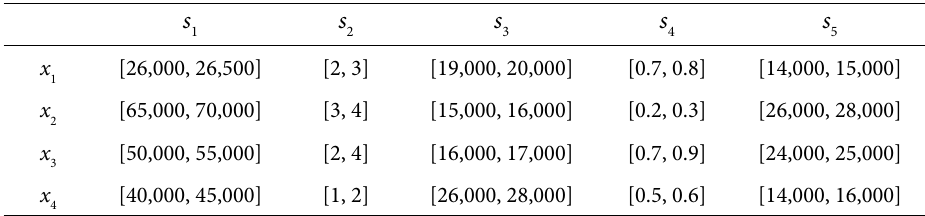
Table 2. Uncertain decision